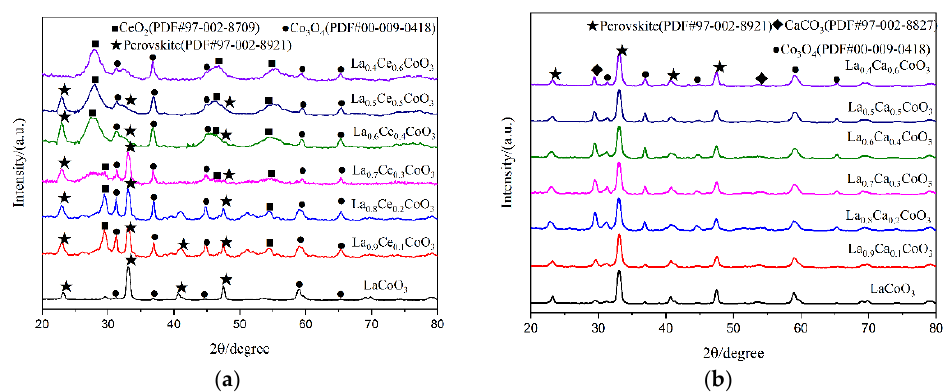
Figure 5. XRD patterns of catalyst samples: ( a ) La 1−x Ce x CoO 3 catalyst samples; and ( b ) La 1−x Ca x CoO 3 catalyst samples.